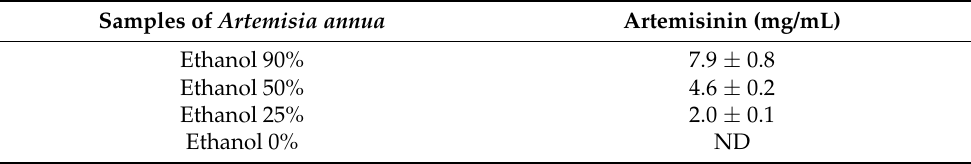
Table 1. Quantification of artemisinin in extracts of Artemisia annua at scalar concentrations of